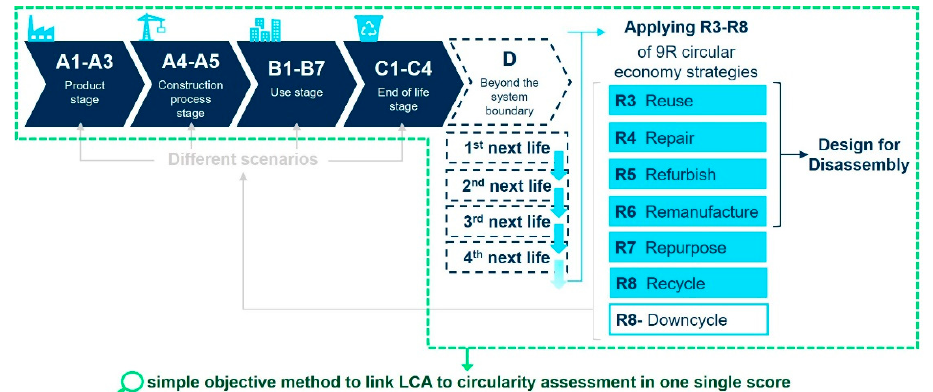
Figure 1. The aim of this paper: linking LCA (left part of the figure based on EN 15804 [23]) to circularity assessment (assessing the application of circular economy strategies as visualized in the right part of the figure) in one single score without the need to define case-specific scenarios.